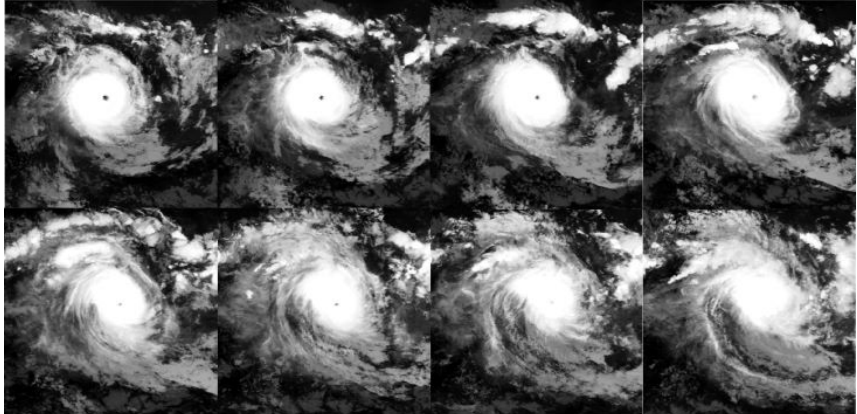
Figure 3. TIR band (10.8 µ m central wavelength), gray-scale imagery of Faraji cyclone, as observed by the SEVIRI radiometer, between 12.00 UTC of 8 February 2021 and 09.00 UTC of 9 February 2021, in 3-h